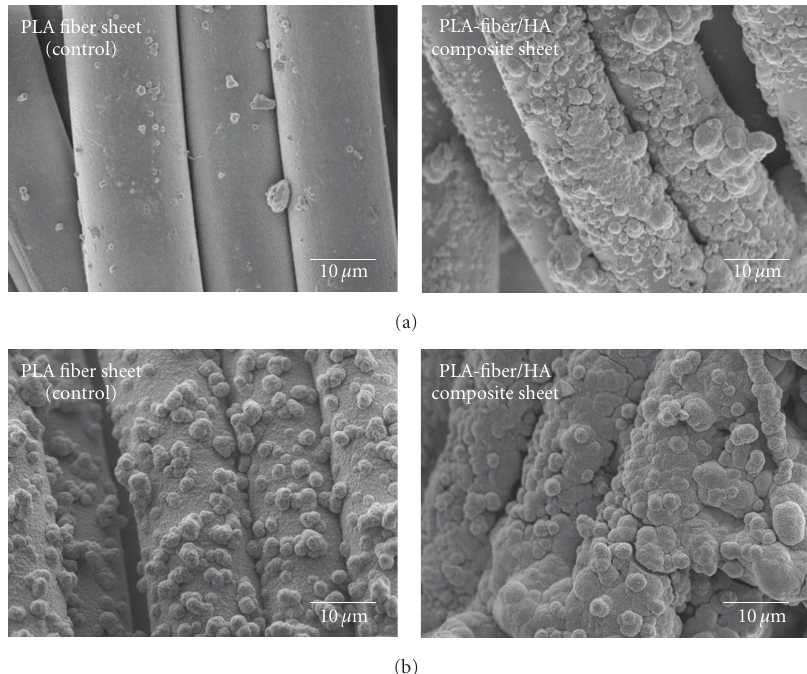
Figure 5: FE-SEM photographs showing the surface appearances of the PLA-fiber/HA composite sheet and PLA-fiber sheet after immersion in HBS solution. (Original magnification × 2,000). (a) After 1 day of immersion. (b) After 7 days of immersion. Precipitate formation is observed on the surface of the PLA-fiber/HA composite sheet after immersion in HBS solution for only 1